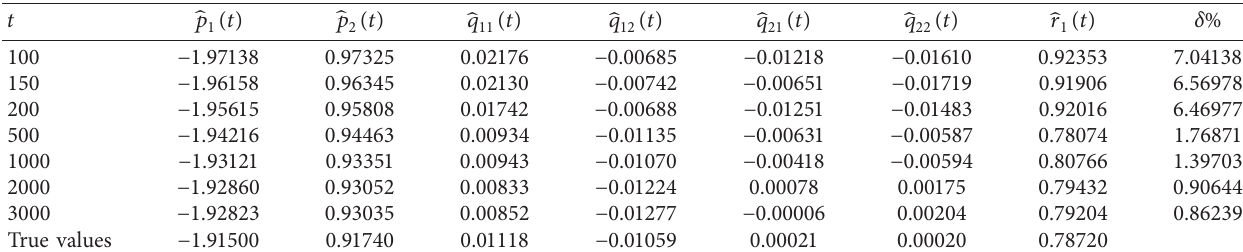
Table 2: The parameter estimates and their errors with recursive extended least squares algorithm ( σ 2 � 0 . 10 2 ) .